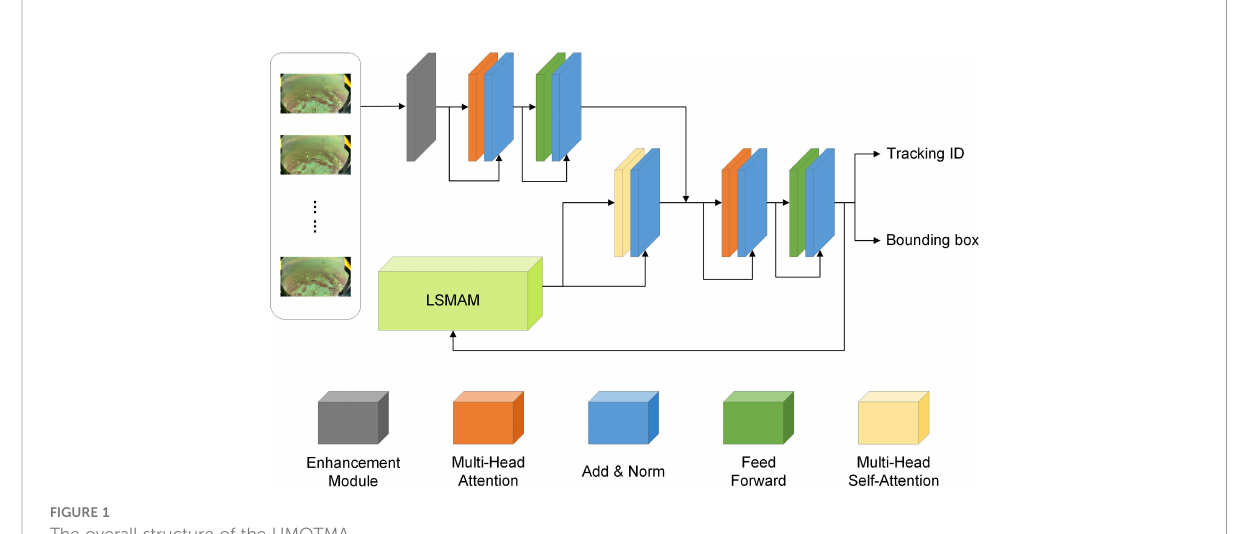
FIGURE 1 The overall structure of the